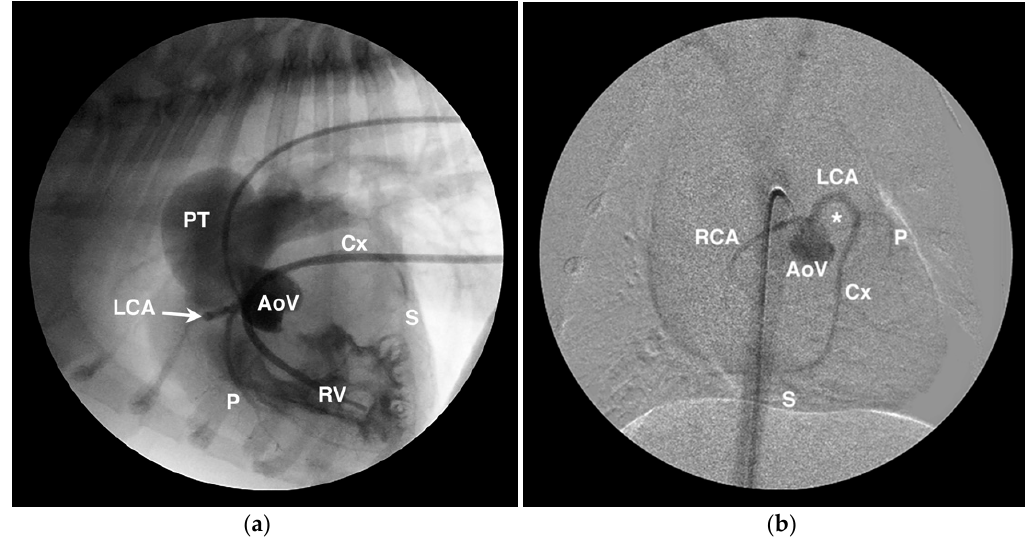
Figure 7. Angiographic examples of anomalous coronary artery origin and course. ( a ) Lateral angiogram from a French bulldog showing simultaneous aortic root (AoV) and right ventricular (RV) injections that demonstrate RV hypertrophy, post-stenotic dilation of the pulmonary trunk (PT), and a single right coronary ostium from which arises the left coronary artery (LCA) that encircles the RV outflow tract before branching into the paraconal interventricular (P), circumflex (Cx), and subsinuosal (S) branches. ( b ) Digitally-subtracted angiogram in a ventrodorsal oblique projection from the same dog as in panel ( a ) showing similar anatomy and highlighting the prepulmonary course of the LCA around the RV outflow tract which occupies the position highlighted by the *.